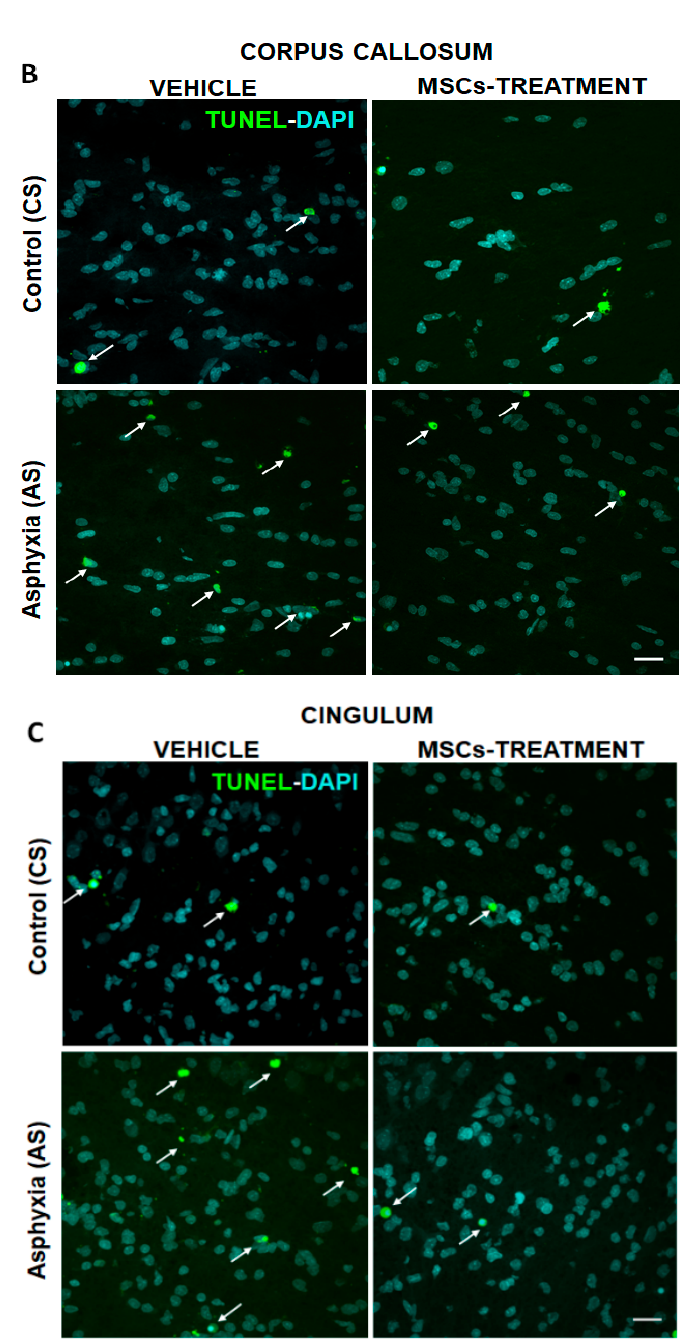
Figure 3. Effect of MSCs treatment on cell death induced by perinatal asphyxia (PA), measured at P7 in external capsule ( A ); corpus callosum ( B ); and cingulum ( C ) of rat neonates. Representative microphotographs obtained by confocal microscopy showing TUNEL (green), DAPI (nuclei, blue)-positive cells in external capsule (3A); corpus callosum (3B); and cingulum (3C) from vehicle- and MSCs-treated control (CS) and asphyxia-exposed (AS) neonates. Scale bar: 20 μ m. ( A – C ). The number of TUNEL-DAPI cell/mm3 is increased when comparing vehicle-treated AS versus CS neonates, but the number of TUNEL-DAPI cell/mm 3 is decreased in MSCs- versus vehicle-treated AS rat neonates in all evaluated regions.